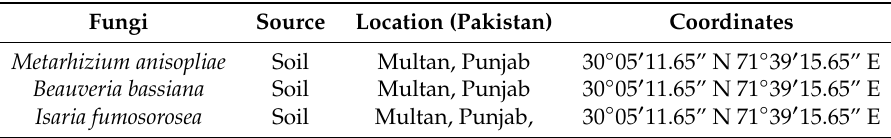
Table 1. Isolates of entomopathogenic fungi from